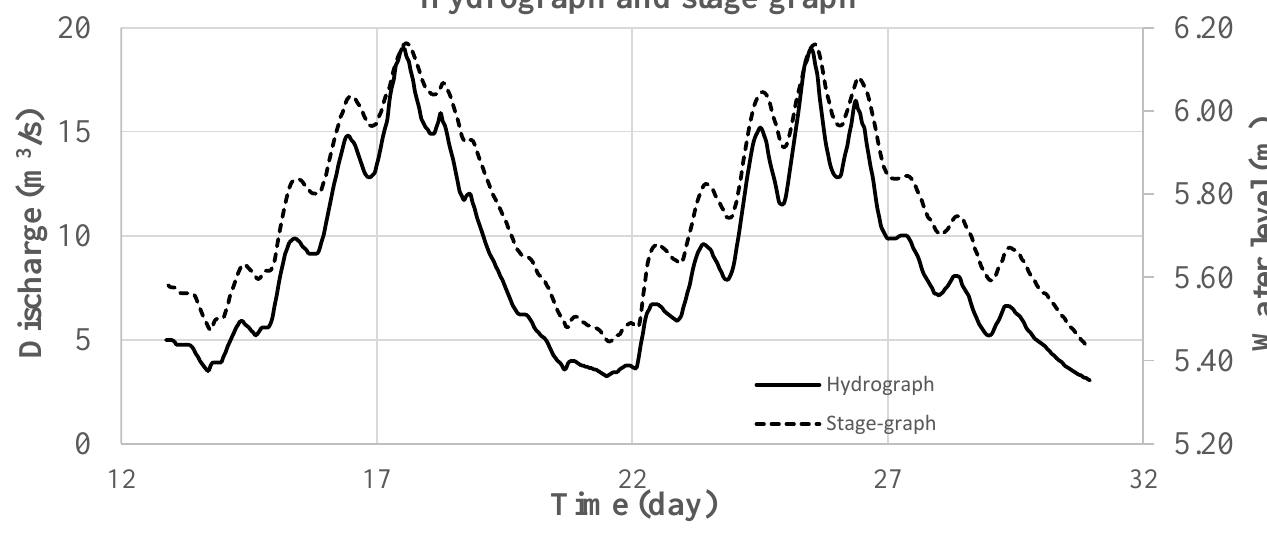
Figure 7. Hydrograph at the inlet and stage graph at the outlet.